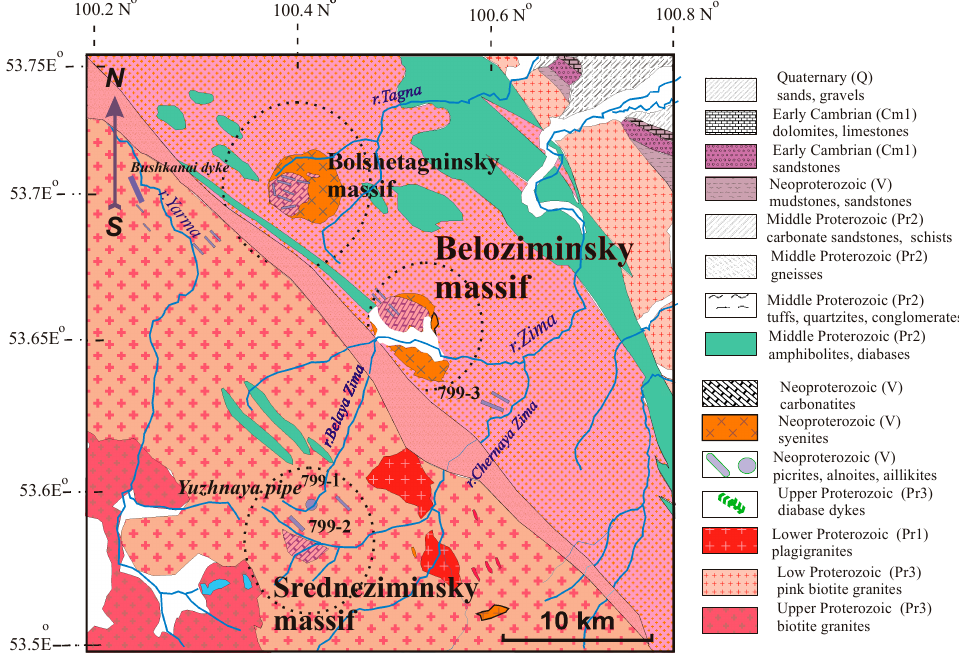
Figure 3. Geological scheme of the Nizhnesayansky alkali ultramafic carbonatite complex including Beloziminsky, Sredneziminsky; Bolshetagninsky massifs (redrawn from [35]). Minerals 2020 , 10 , x FOR PEER REVIEW